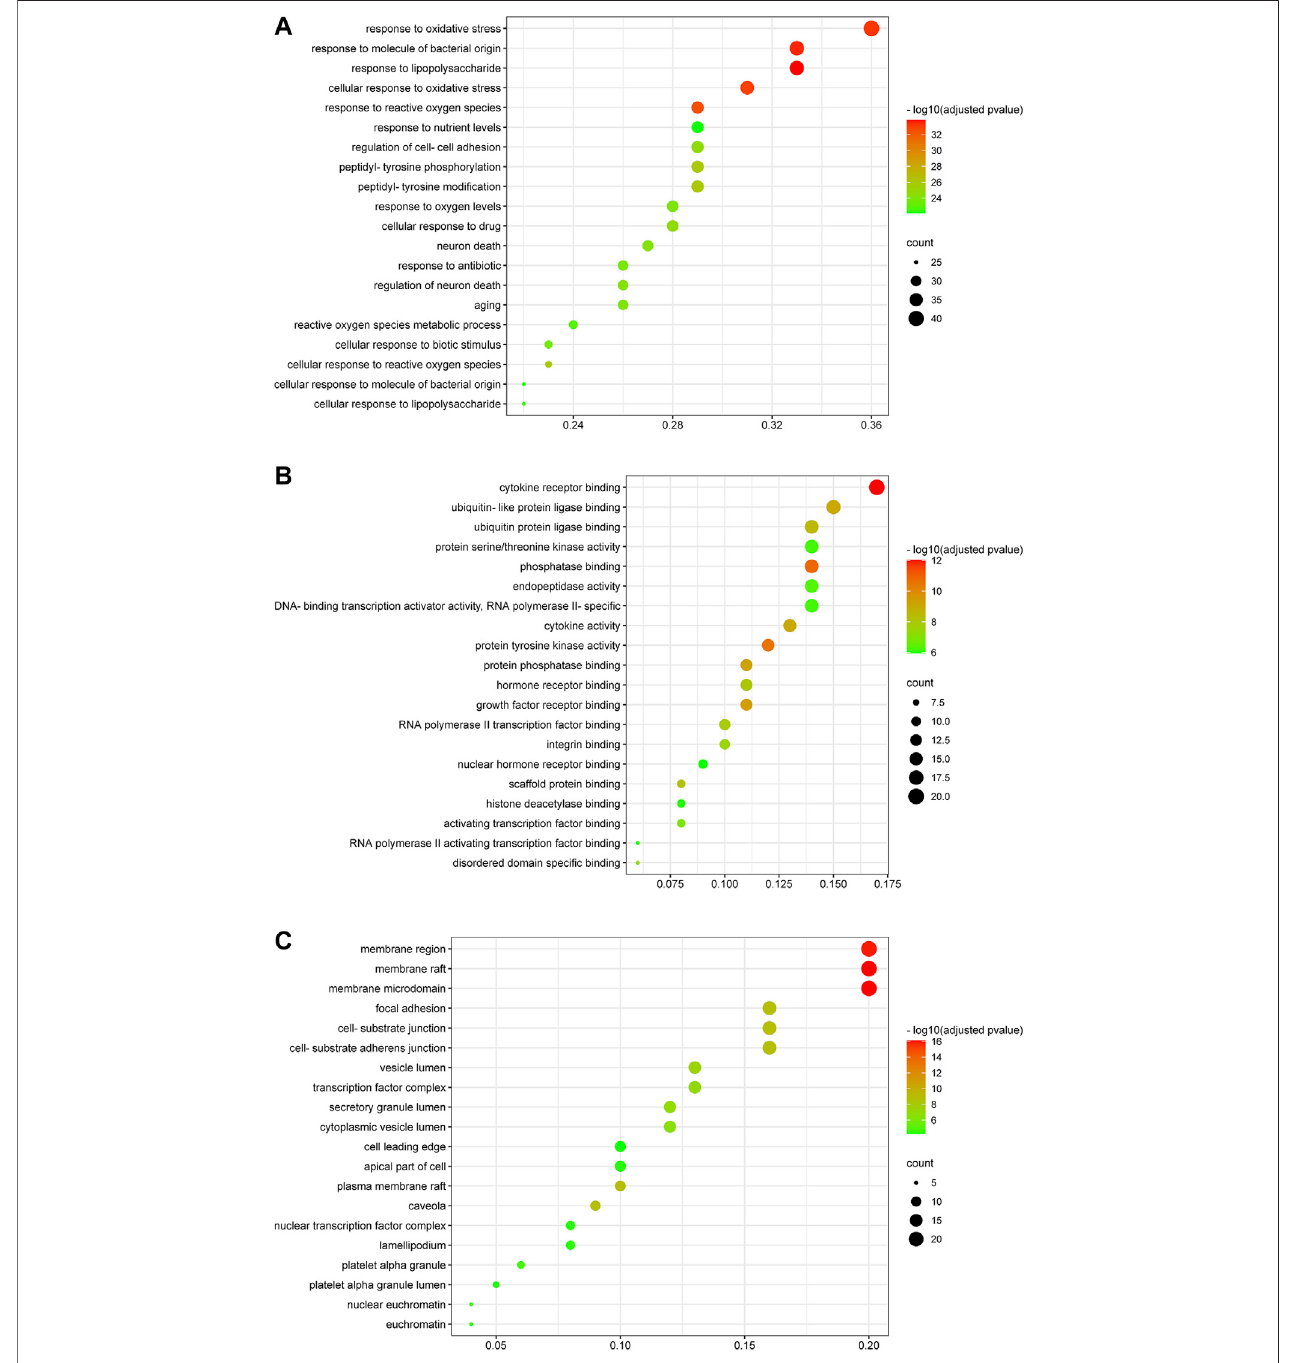
FIGURE7 | Gene ontology enrichmentanalysis ofcritical targets. The sizeof thenode represents the number of genesinvolved in the GOterm, and the colorfrom green to red indicates the − log10 (adjusted p value) from small to large. (A) Biological process enrichment results of critical targets. (B) Molecular function enrichment results of critical targets. (C) Cellular components enrichment results of critical